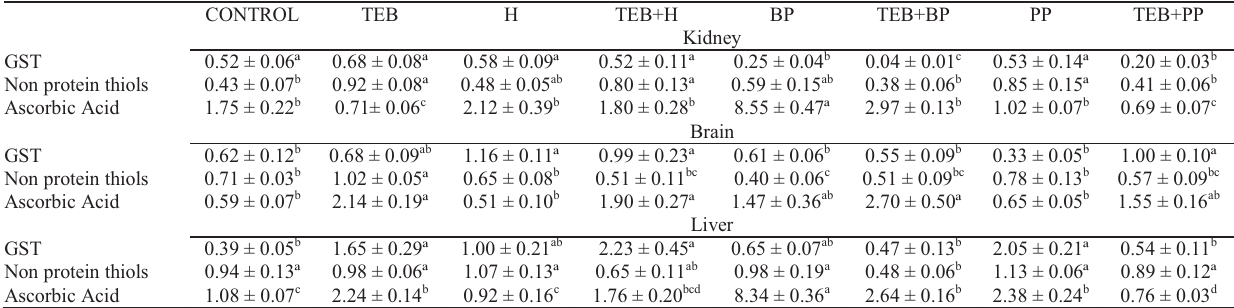
Table 1. Glutathione-S-transferase, non protein thiols and ascorbic acid in Rhamdia quelen exposed to tebuconazole, honey, propolis or bee pollen and the combination of bee products and the fungicide. Different small letter after the means indicates significant difference, ANOVA followed by Tukey’s multiple range test, P <0.05, n = 10. Units: glutathione S-transferase, (cid:2) mol GS-DNB min -1 mg protein -1 ; reduced glutathione, (cid:2)mol GSH g -1 of wet tissue; non protein thiols, (cid:2)mol SH g -1 of tissue; ascorbic acid, (cid:2)mol g -1 of tissue. Different small letters indicates statistical differences between the means (ANOVA followed by Tukey´s multiple range